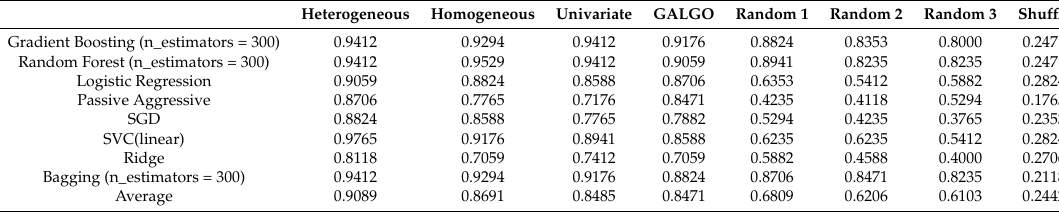
Table 3. Accuracy on the 10% data for testing the feature selection algorithm: Results for the signatures found by the heterogenous recursive ensemble feature selection algorithm, the homogeneous recursive ensemble feature selection algorithm, K-Best feature selection algorithm using f-score as selection citeria, 3 random feature subsets and a random shuffle of the test labels.